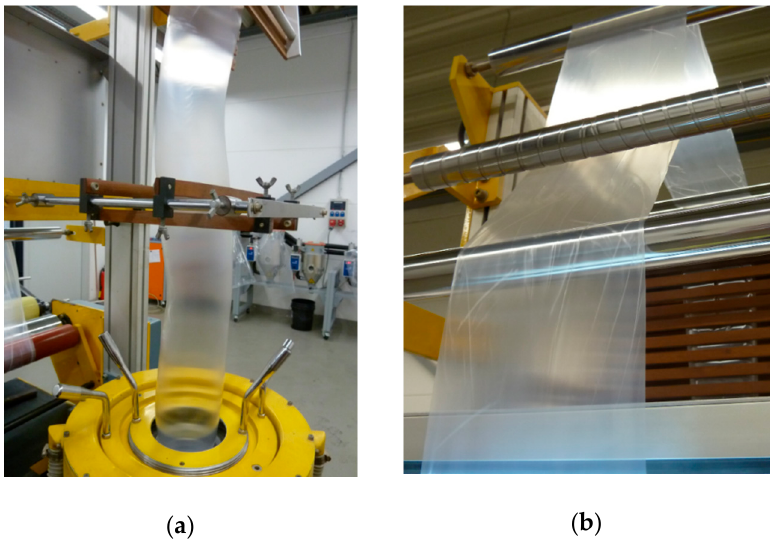
Figure 1. Observation of the instability of the blown film production process: ( a ) helical instability; ( b ) blown films with wrinkles.